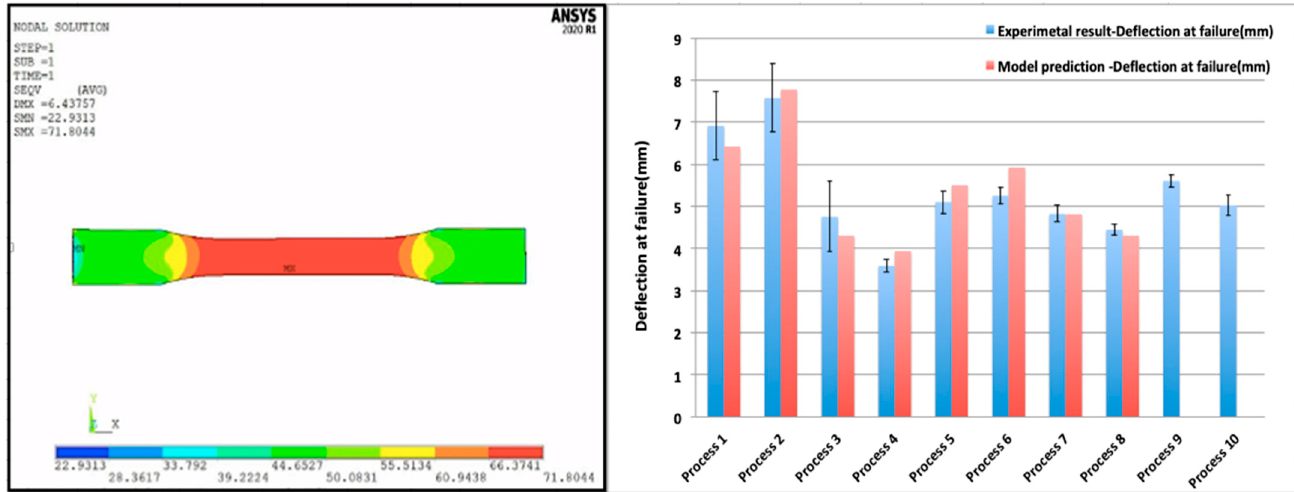
Figure 5. Simulation results for predicted de fl ection at failure for process is shown on the left (6.44 mm) and other processes are similarly modeled and compared with experimental results, as shown on the right; however, processes 9 and 10 are left out, as the e ff ect of temperature is not considered due to lack of creep studies. Simulation results are based on a material model which may have a 1 to 7.5% error [27].